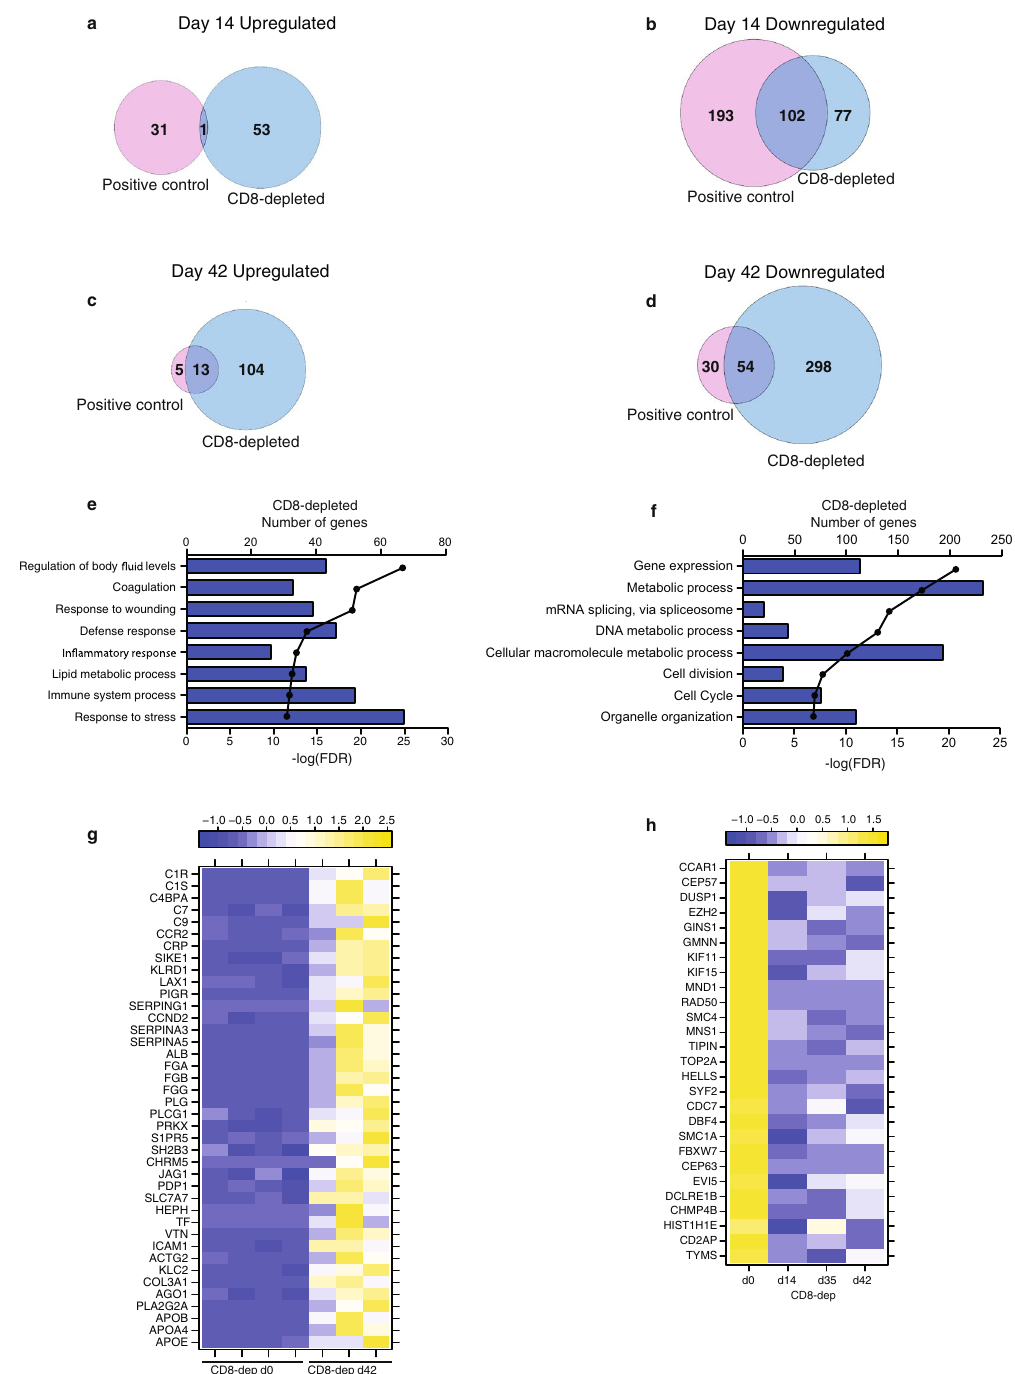
Figure 6. Gene expression changes persist in protected animals. ( a ) Venn diagram of genes upregulated 14 dpi in positive control and CD8-depleted animals. ( b ) Venn diagram of genes downregulated 14 dpi in positive control and CD8-depleted animals. ( c ) Venn diagram of upregulated genes 42 dpi in positive control and CD8- depleted animals. ( d ). Venn diagram of genes downregulated 42 dpi in positive control and CD8-depleted animals. ( e , f ) Bar graph depicting the most statistically significant GO terms enriched among upregulated genes ( e ) and downregulated genes ( f ) in CD8-depleted animals 42 dpi ( g ) Heatmap of genes upregulated 42 dpi in CD8-depleted animals mapping to “Coagulation” and “Immune System Process”; each column represents 1 animal in the CD8-depleted group (n = 3 at 42 DPI). ( h ) Heatmap of genes downregulated 42 dpi in CD8- depleted animals mapping to “Cell Cycle”; each column shows median transcript RPKM counts of all animals in the CD8-depleted group at each